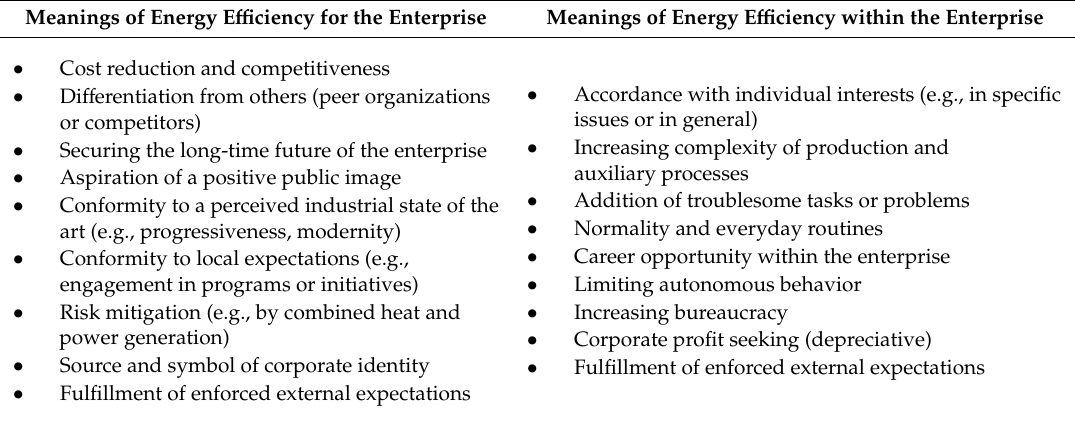
Table 4. Meanings of energy e ffi ciency for and within the enterprise (energy e ffi ciency